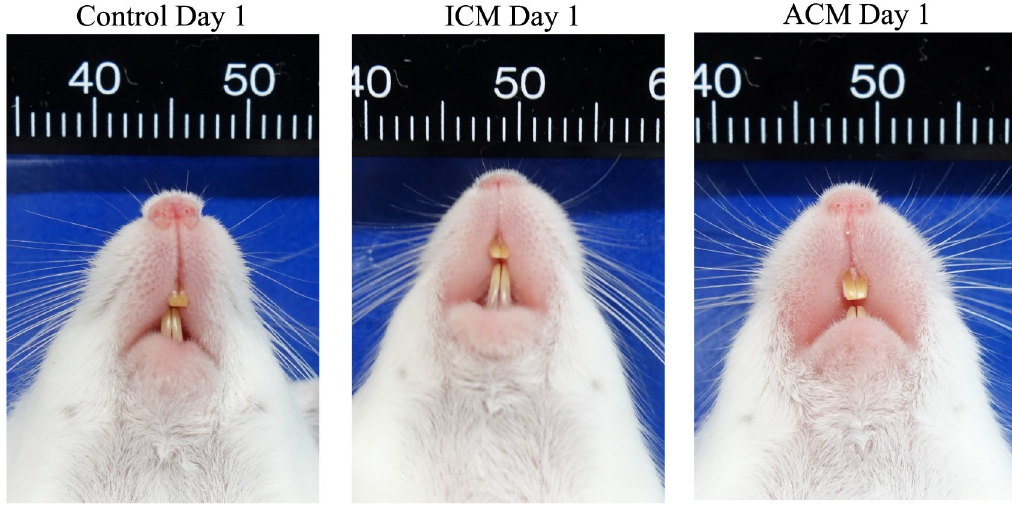
Fig 2. Macroscopic findings of the oral mucosa in Ni-induced allergic mice. Significant redness and swelling are evident in the buccal area of ACM mice compared with control and ICM mice at day 1 after challenge.